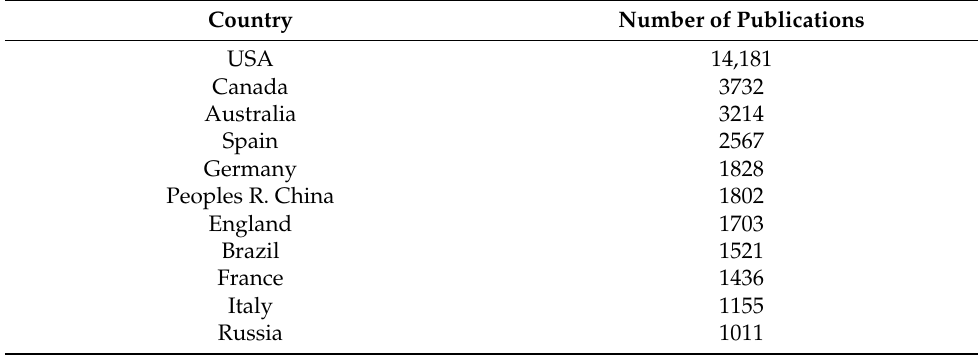
Table 3. Number of publications by countries which have more than 1000 publications.